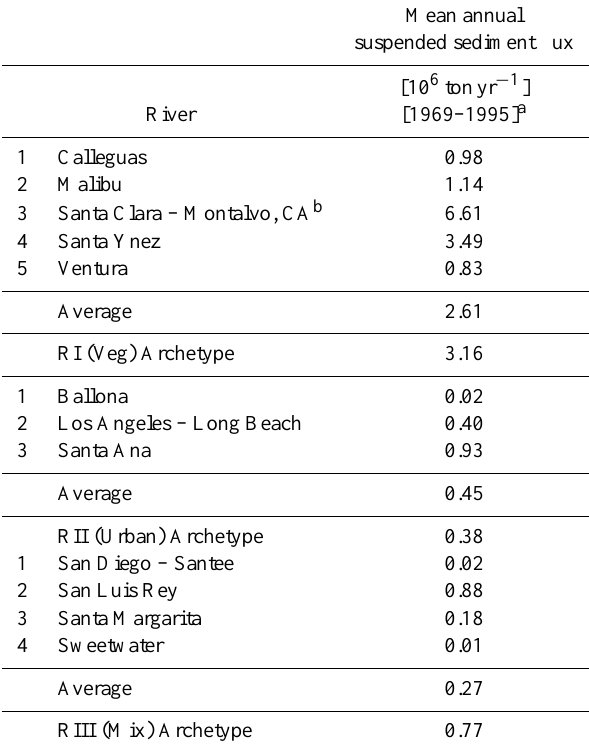
Fig. 8. Recurrence interval of annual storm sediments due temperature increase and precipitation variability. Left axis corresponds to the range in percent deviation (shaded area) in storm sediments. Right axis corresponds to the baseline simulation of storm sediments (dotted line) for (a) Region I, (b) Region II and (c) Region III.